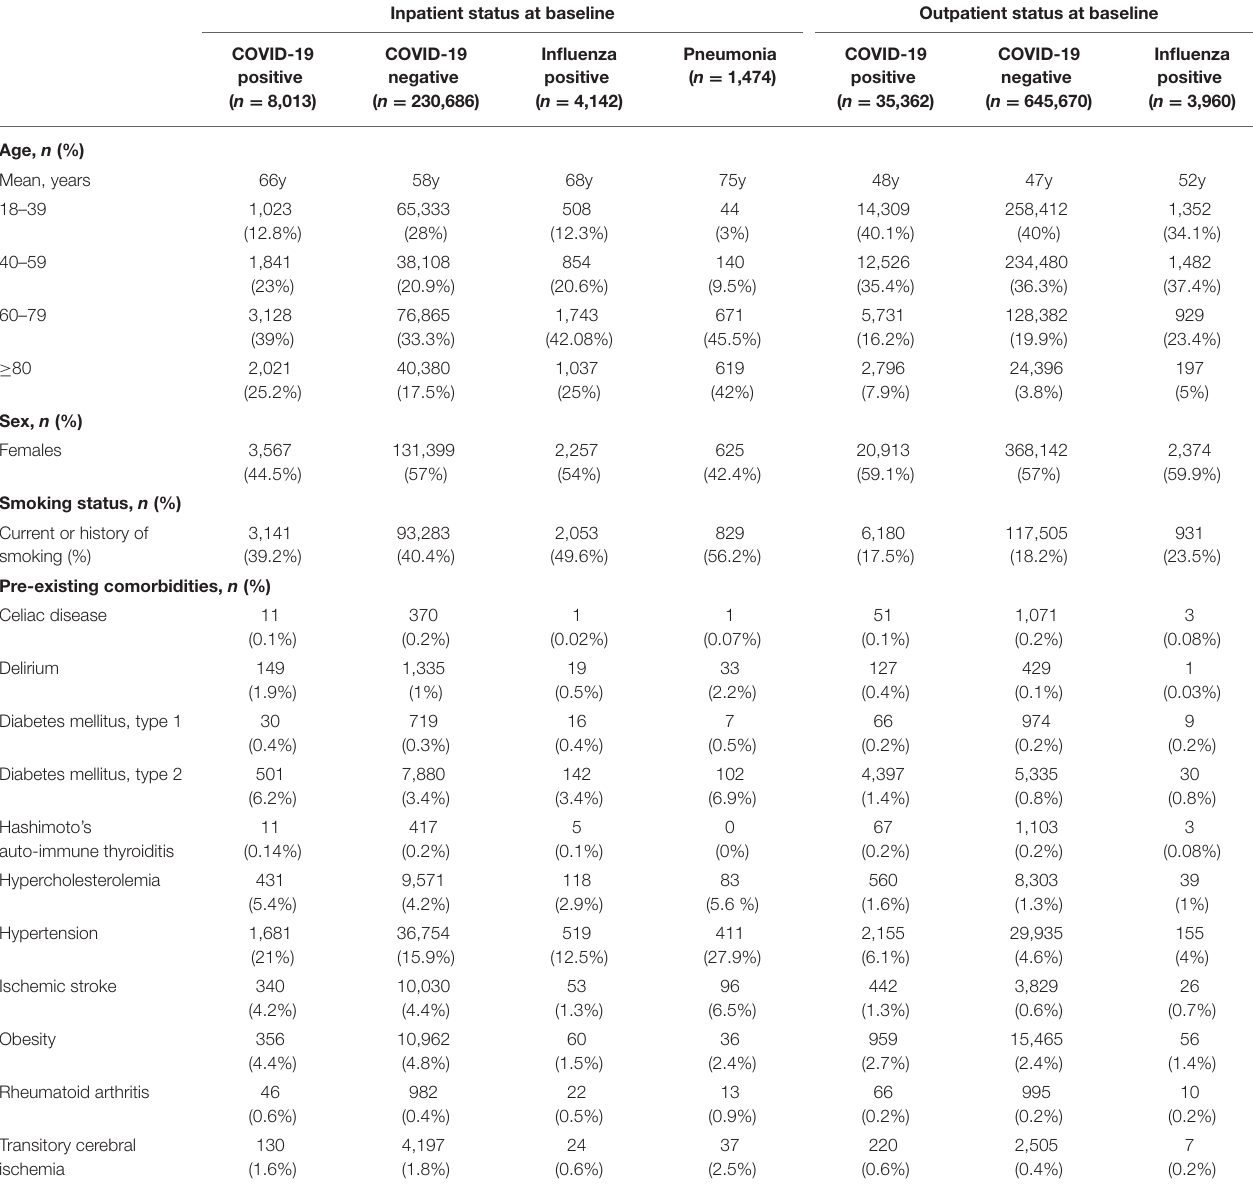
TABLE 1 | Clinical characteristics and demographics at